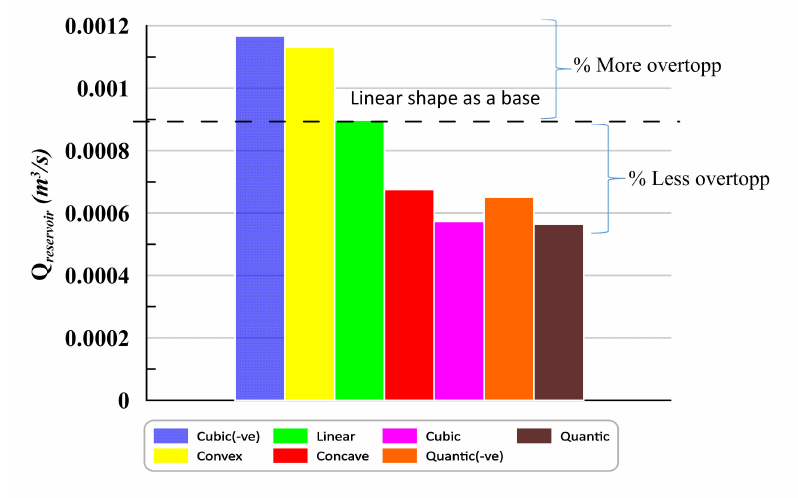
Figure 13. Overtopping rate for di ff erent ramp shapes.